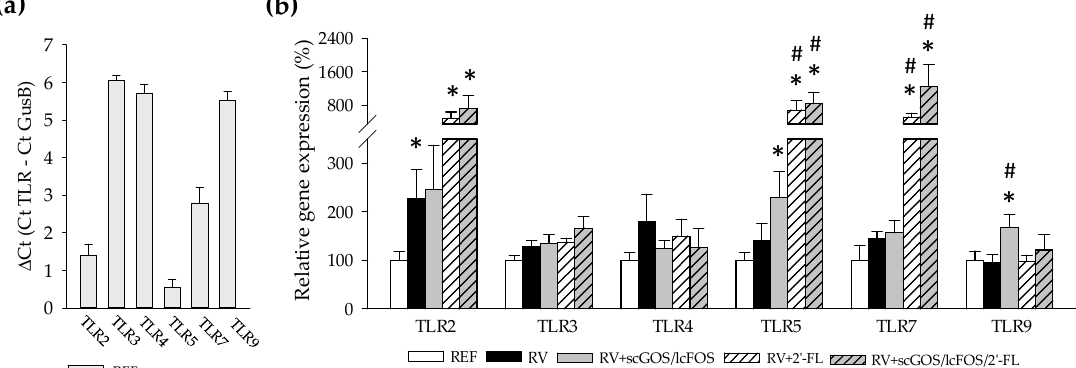
Figure 2. Small intestine gene expression of Toll-like receptors (TLRs) at the peak of diarrhea (day 8): The transcription of TLR2, 4, 5, 7, and 9 were quantified by real-time PCR. ( a ) The ∆ Ct of TLR expression compared to Gusb was calculated in REF animals. ( b ) The relative gene expression in the experimental groups was calculated with respect to REF, which corresponded to 100% of transcription. Results are expressed as mean ± S.E.M. (n = 8 / group). * p < 0.05 compared to the REF group; # p < 0.05 compared to RV group (by the Mann–Whitney U test).